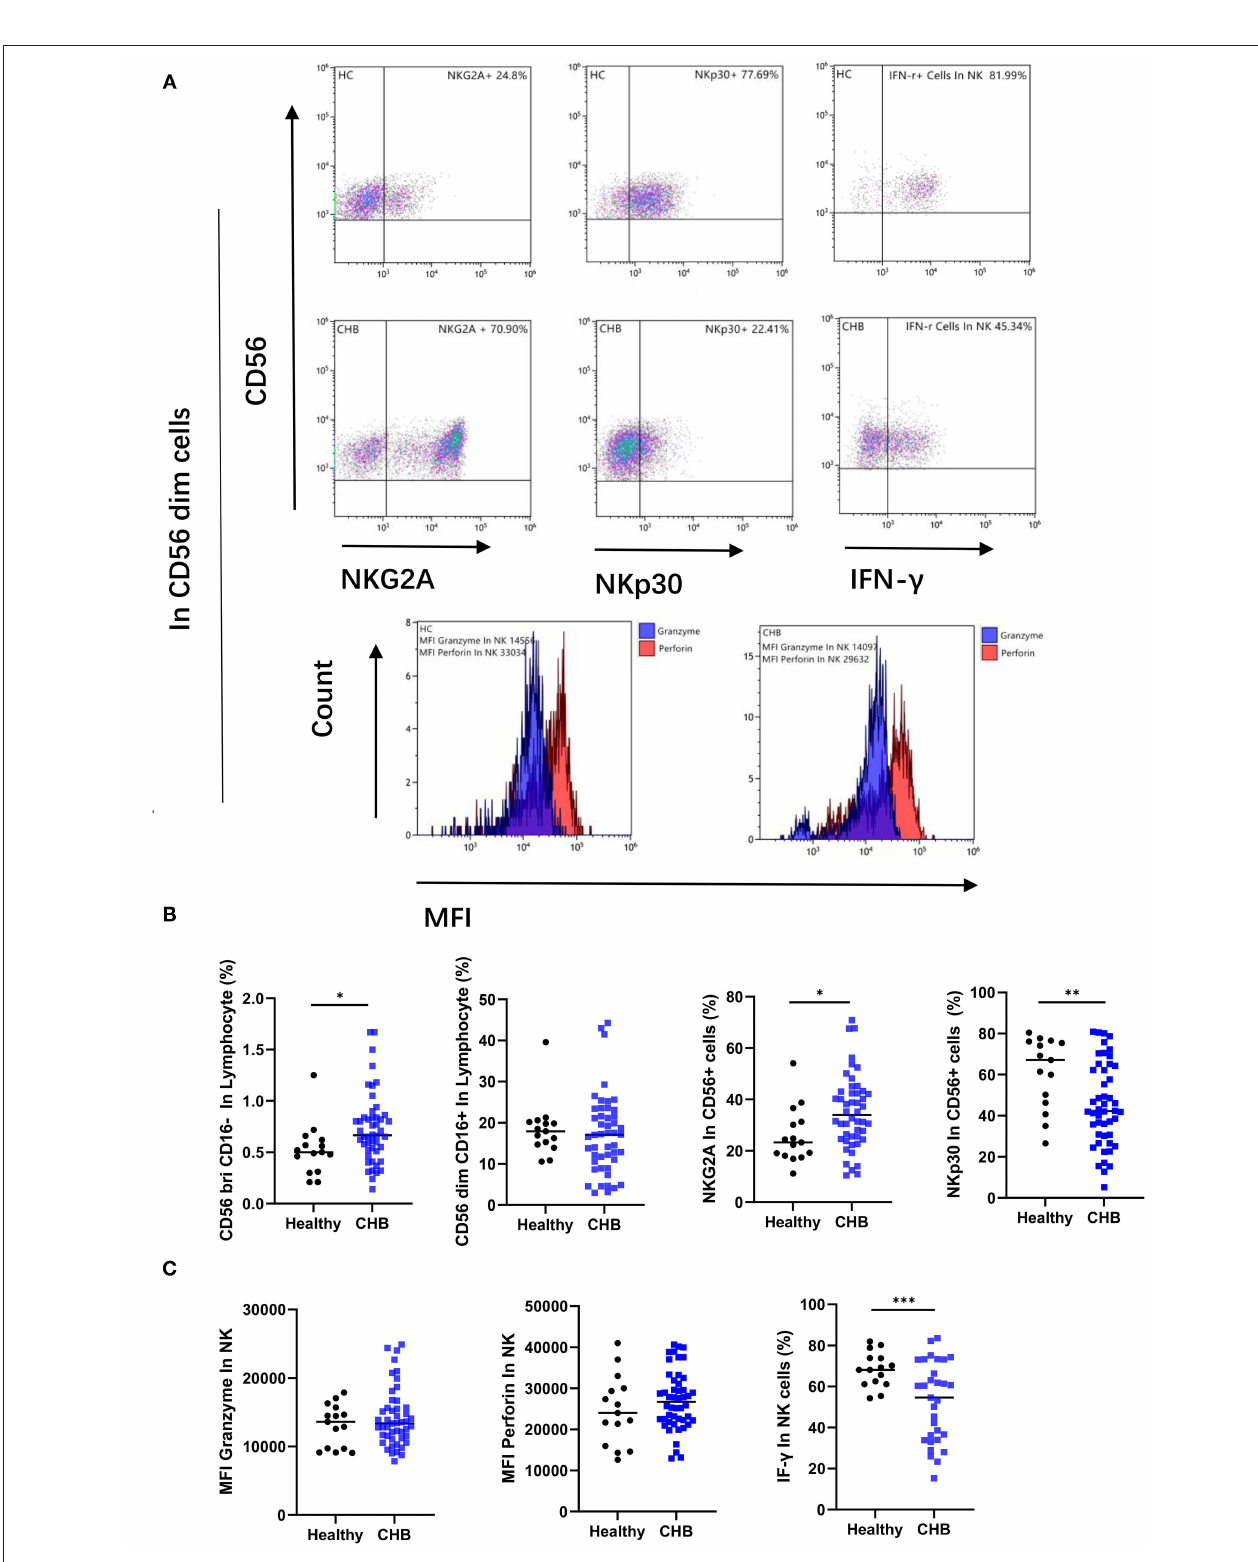
FIGURE 4 | Study of the phenotype and function of natural killer (NK) cells in chronic hepatitis B (CHB) patients. (A) Typical results showing, the expression of the NK receptor, and the secretion of cytokine by NK cells, as well as the Mean fluorescence intensity (MFI) of the granzyme (blue) and perforin (red) in NK cells. (B) Comparison of NK cell numbers and phenotypes in CHB patients ( n = 48) and healthy controls ( n = 15), including the numbers of two subpopulations with high and low CD56 expression, and the expression of NK inhibitory receptor NKG2A and activating receptor NKp30. (C) Comparison of NK cell granzyme, perforin ( n = 48), and IFN- γ secretion functions in CHB ( n = 31) and healthy control groups ( n = 15).